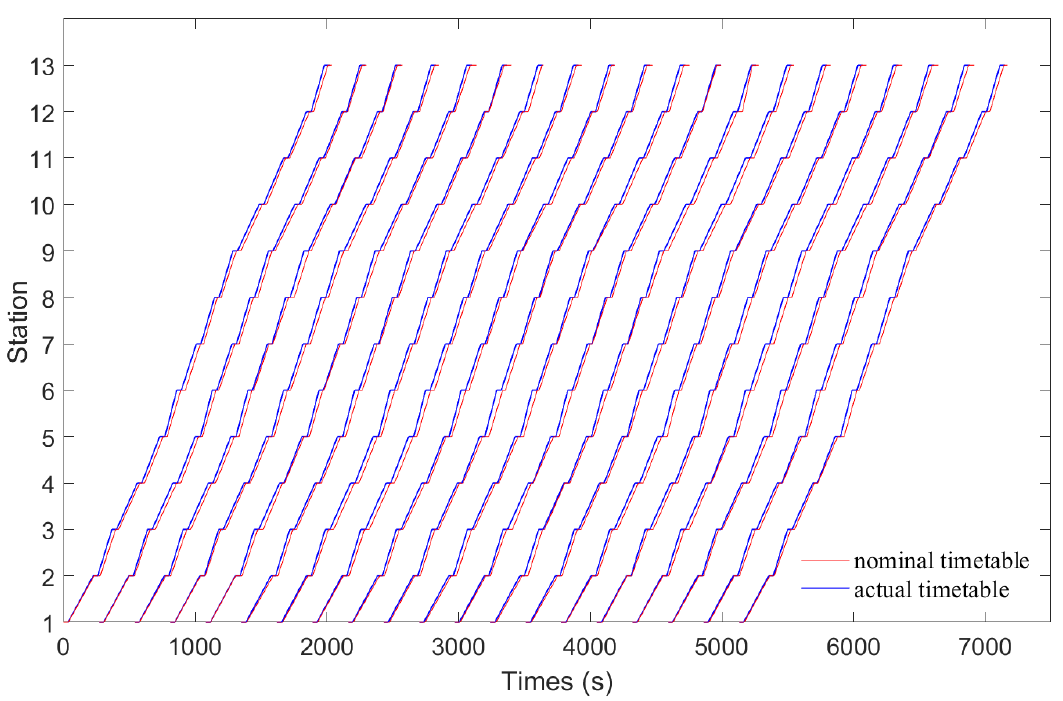
Figure 6. The timetable with train regulation under Case 3 in contrast to the nominal